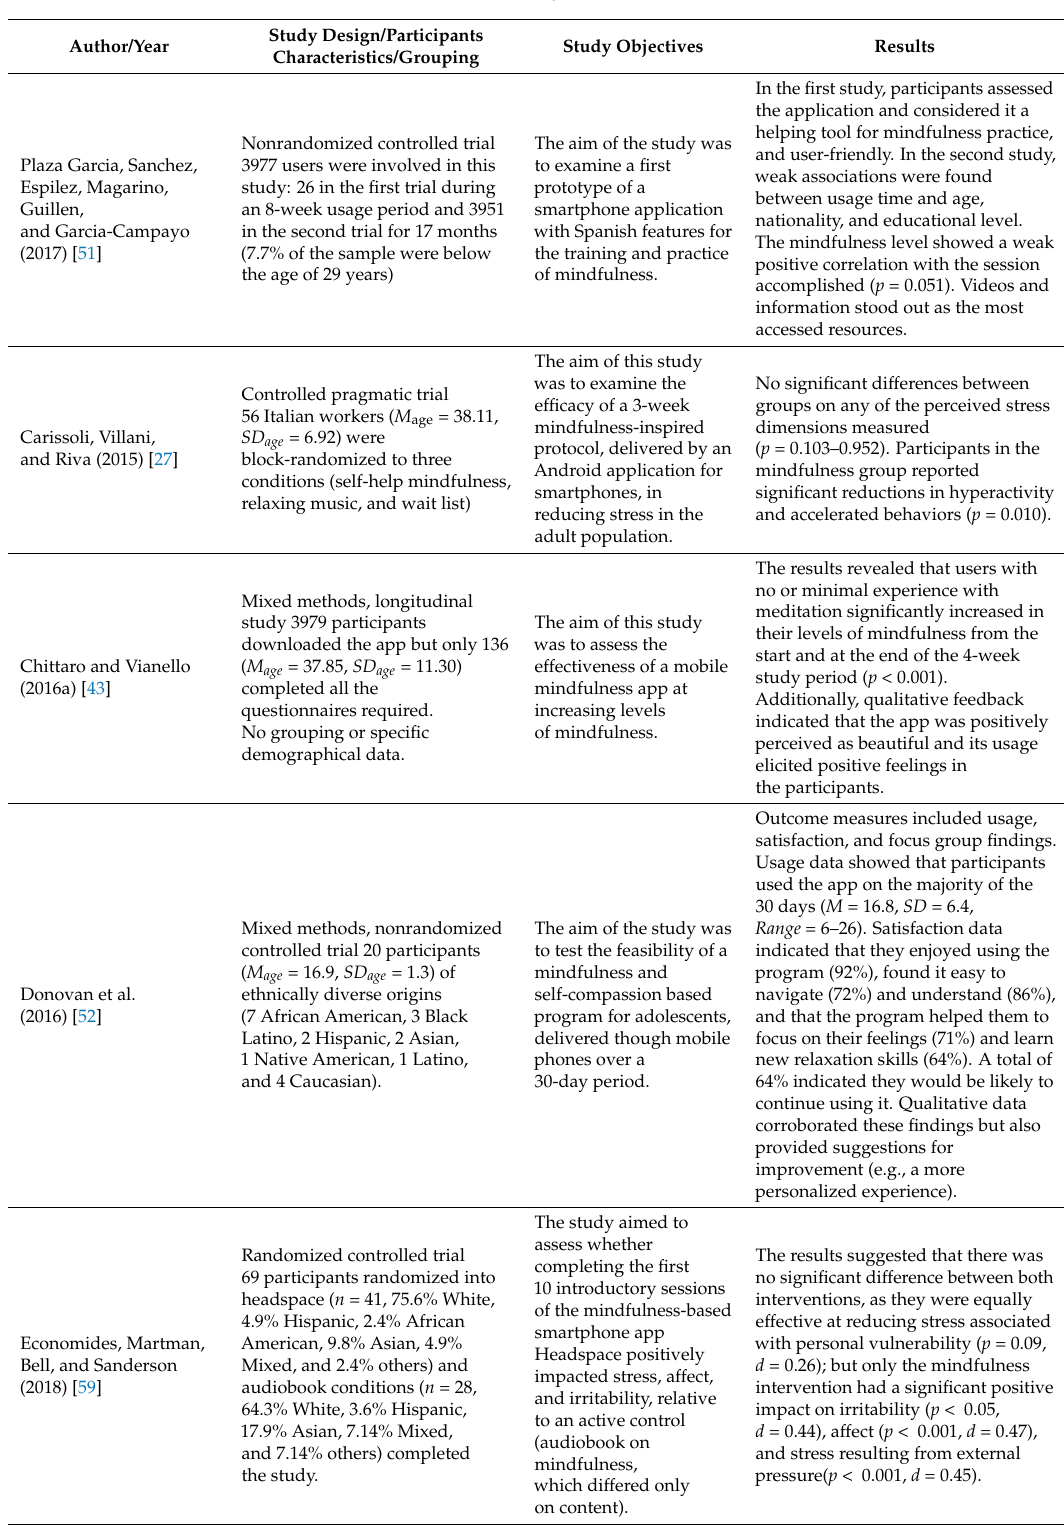
Table 1. Summary of